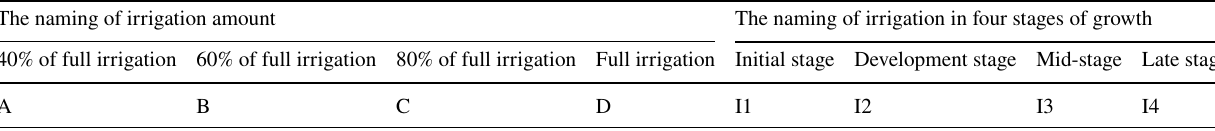
Table 3 The naming of the irrigation values at the different growth stages of the guar bean plant The naming of irrigation amount The naming of irrigation in four stages of growth